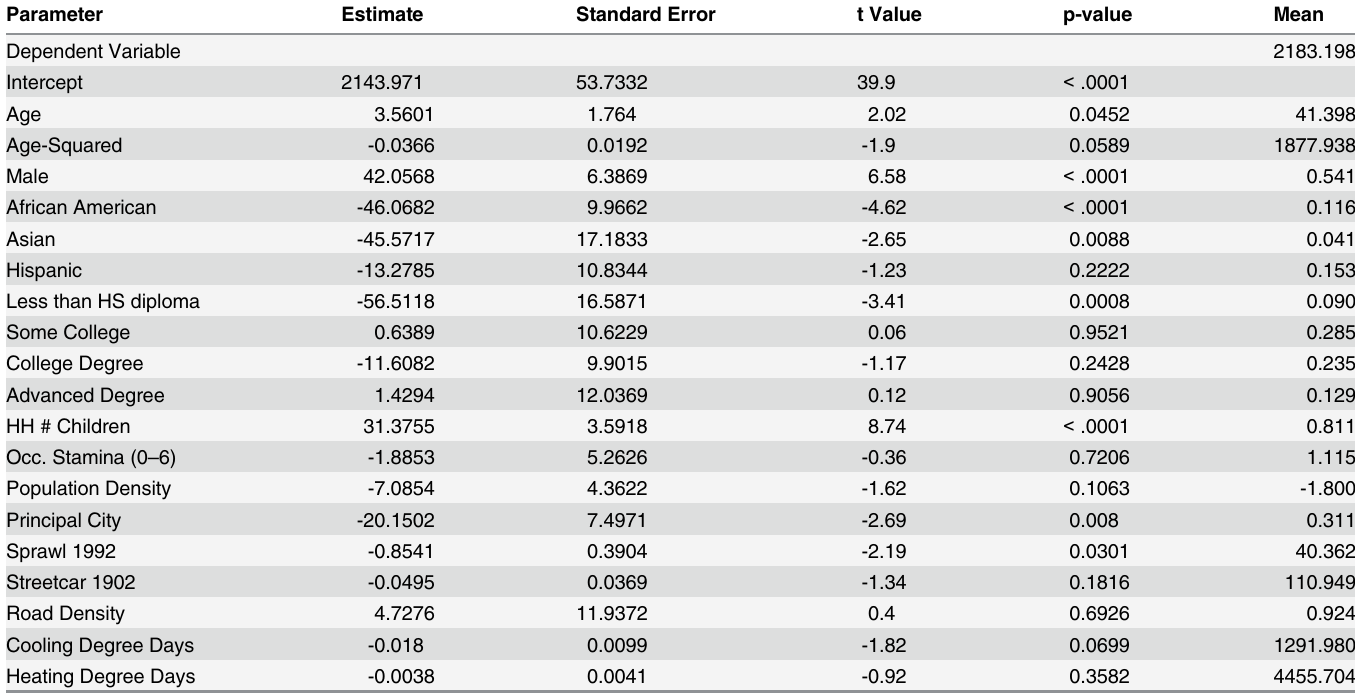
Table 2. Regression on Metabolic Equivalent Minutes in 1440 Minute Diary